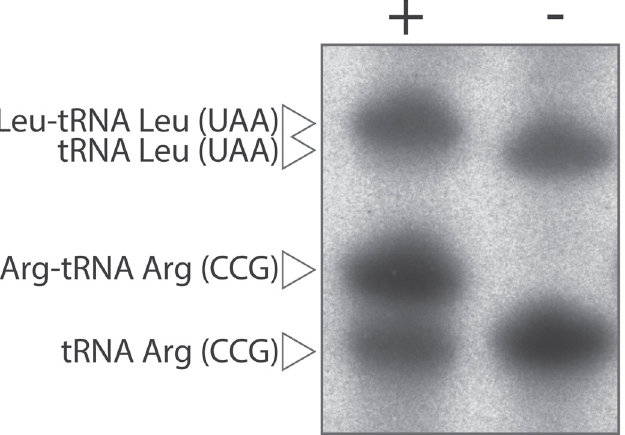
Fig 7. Northern blot analysis of yeast total RNAs under acidic conditions. Total RNAs were extracted and separated under acidic conditions before being transferred onto a nylon membrane. The membrane was probed with a mixture of 32 P-labeled oligonucleotides complementary to tRNA Leu (UAA) and tRNA Arg (CCG). Acylated (+) and deacylated (-) tRNAs were loaded on separate lanes. The shift induced by the presence of arginine residues is significantly greater than the one induced by leucine. In vivo , tRNA Leu (UAA) is not significantly arginylated despite a strong affinity for yArgRS.